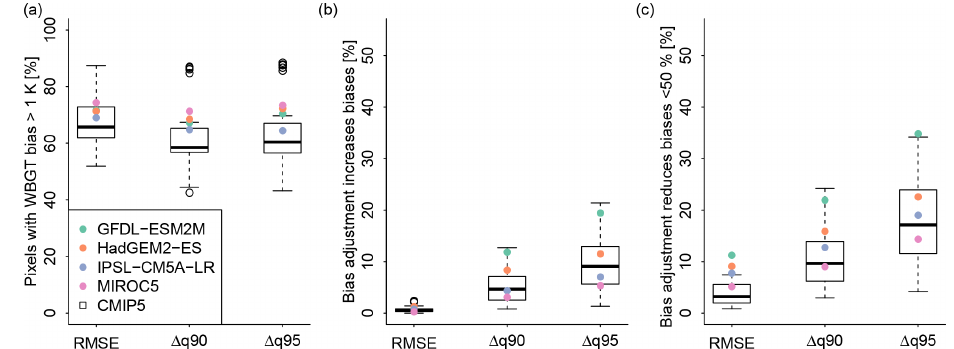
Figure 4. (a) Fraction of grid points for which biases in WBGT are larger than 1K before or after the application of bias adjustment. (b–c) As in Fig. 3 only for WBGT, based on the subset of grid points identified by (a) .